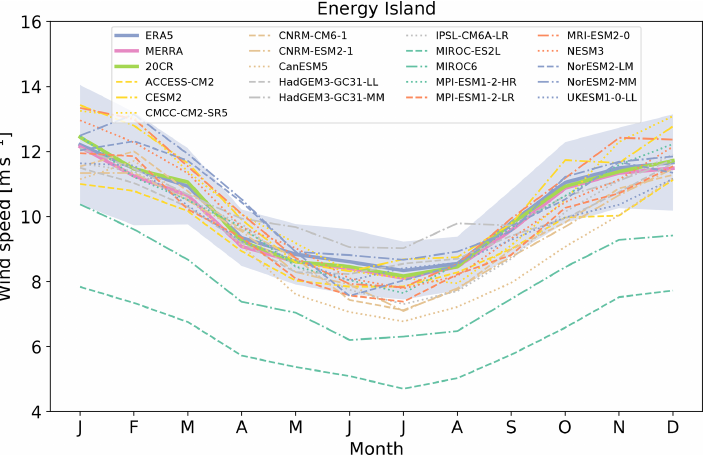
i i o and U m ) at 100ma.g.l. simulated by the CMIP6 models and that provided